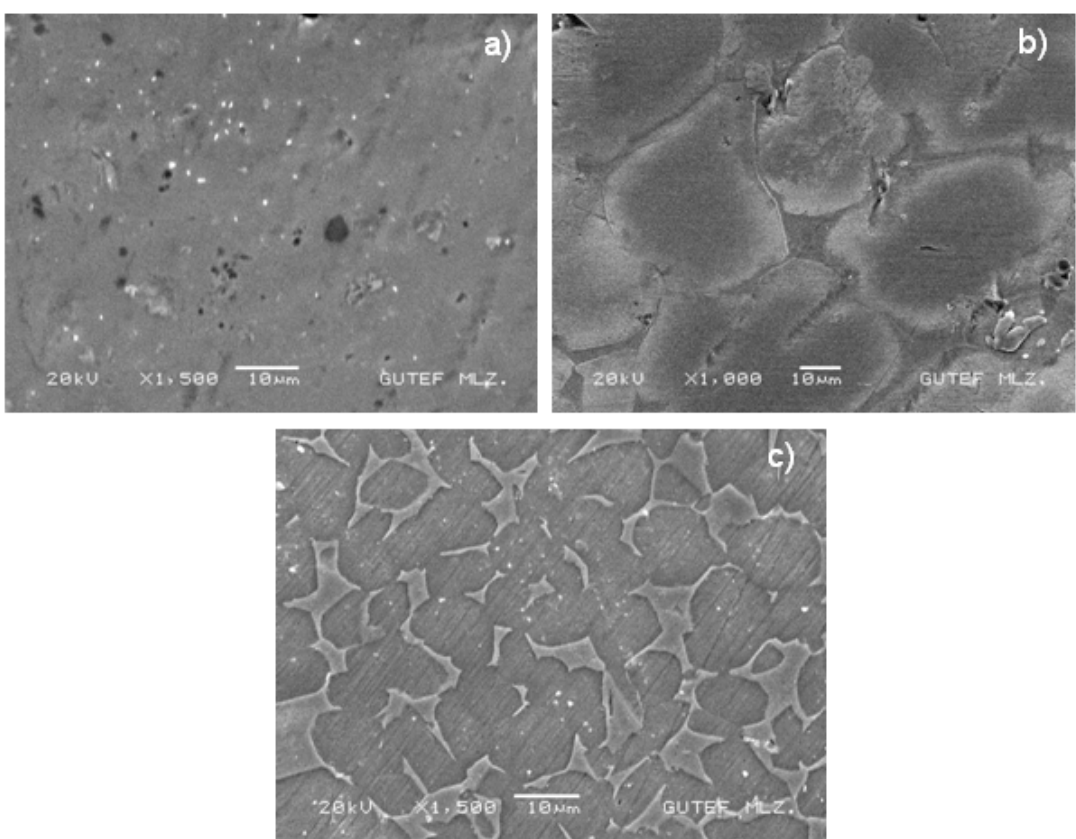
Figure 2. SEM images of samples produced from a) sponge titanium, b) gas atomised titanium powder and c) Ti6Al4V alloy powder.